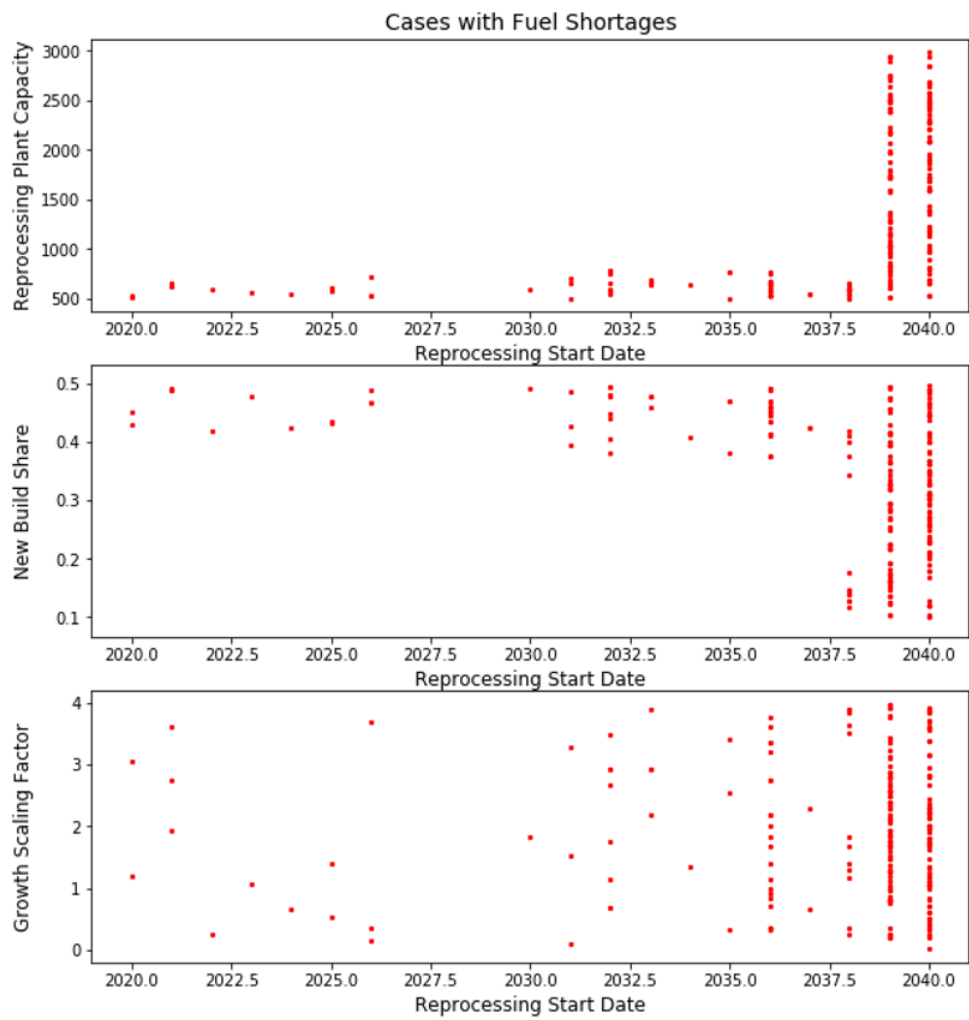
Fig. 5. Parameters of scenarios that resulted in a fuel